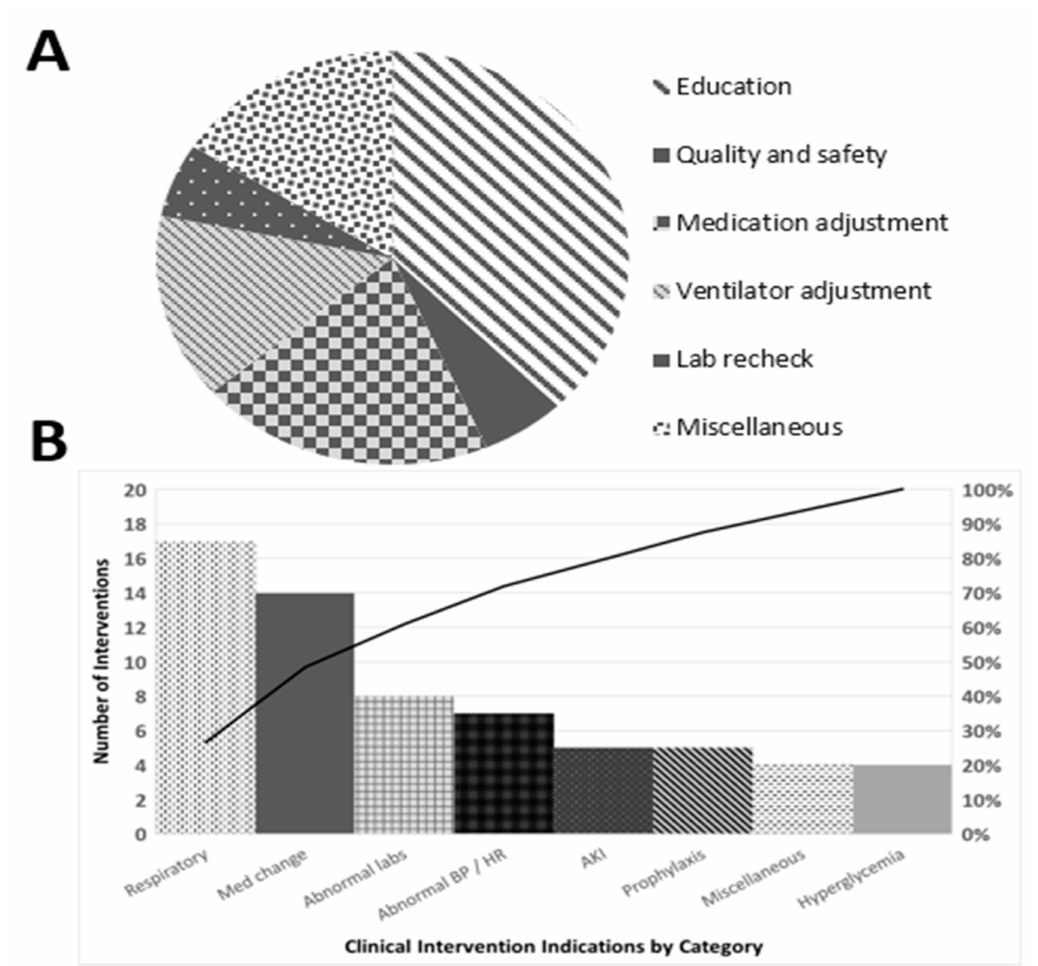
Figure 1. Interventions recorded by eMS: ( A ) distribution of category of interventions; and ( B ) Pareto chart of the indications for clinical